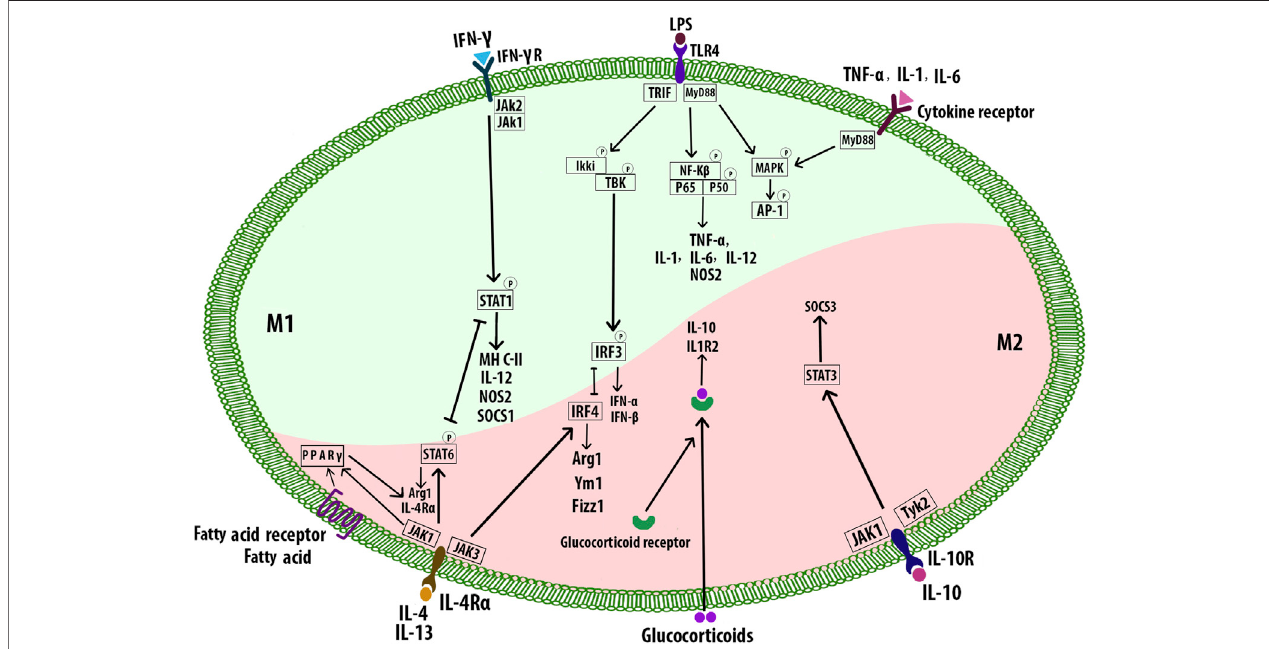
FIGURE 6 | Macrophage polarization signaling pathways. M1 phenotypes express transcription factors such as NF- κ B, STAT1, AP-1, and IRF3. M2 subtypes are stimulatedbytheTh2cytokinesIL-4andIL-13whichbindtothereceptorIL-4R α andcausetheactivationofSTAT6,IRF4,andPPAR- γ .Theintracellular glucocorticoids also promote the transcription of anti-in fl ammatory genes. IL-10 activates STAT3 and subsequent upregulation of SOCS3. Signal transducer and activator of transcription 1 (STAT1), interferon regulatory factor -3 (IRF3), nitric oxide synthase 2 (NOS2), suppressor of cytokine signaling 3 (SOCS3), arginase 1 (Arg1).